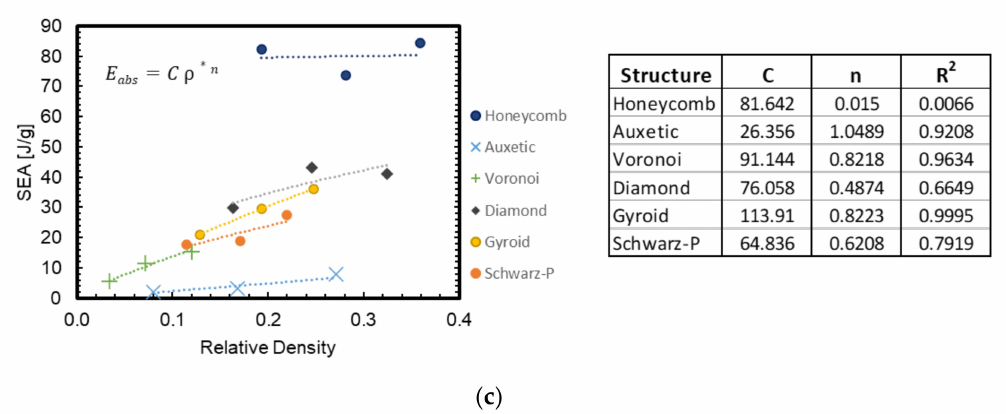
Figure 24. ( a ) Normalized effective modulus, ( b ) normalized maximum transmitted stress, and ( c ) SEA, all plotted as a function of relative density. The adjacent tables provide the fit parameters, with the R 2 value indicative of the quality of the fit.